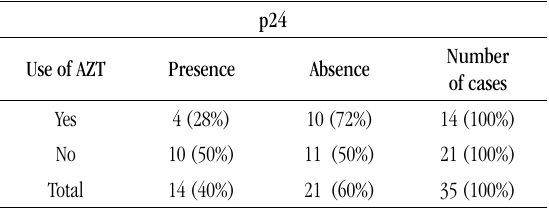
tABLE 2 – Correlation between the use of AZT in pregnant women and p24 viral protein in